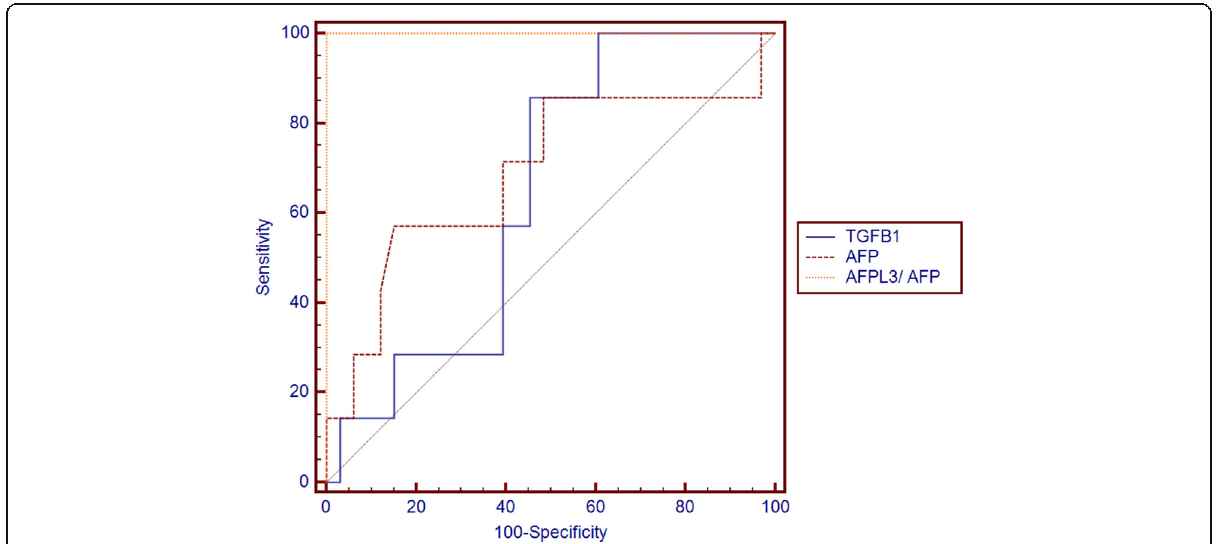
Fig. 1 Receiver operating curve (ROC) demonstrating sensitivity and specificity of TGFB1, AFP, and AFP-L3% in prediction of tumor